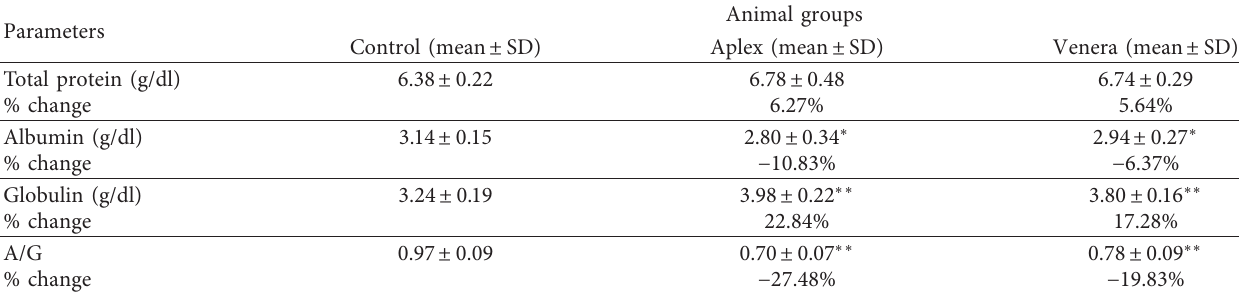
Table 4: Protein profile indices in sera of control and treated animal